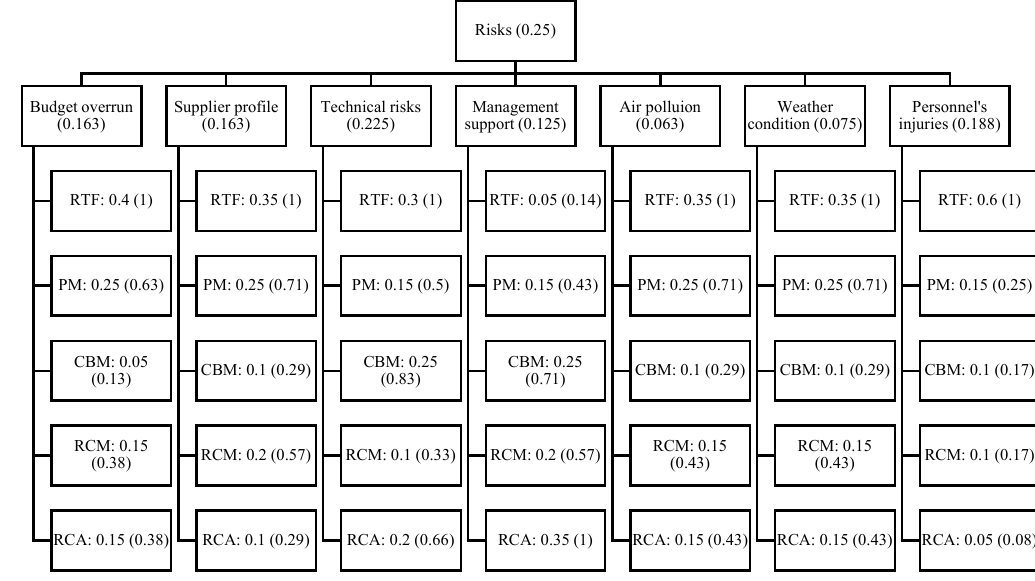
Fig. 6. Hierarchy chart of evaluated risks and